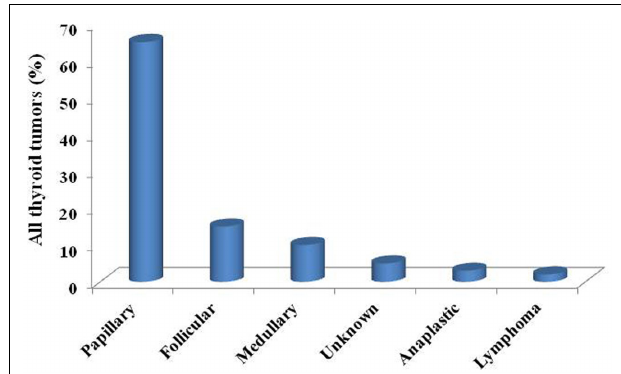
FIGURE 1 |The prevalence of different histotypes among all thyroid tumors: a clear higher prevalence of papillary thyroid cancer (about 80%) is usually reported in all series.